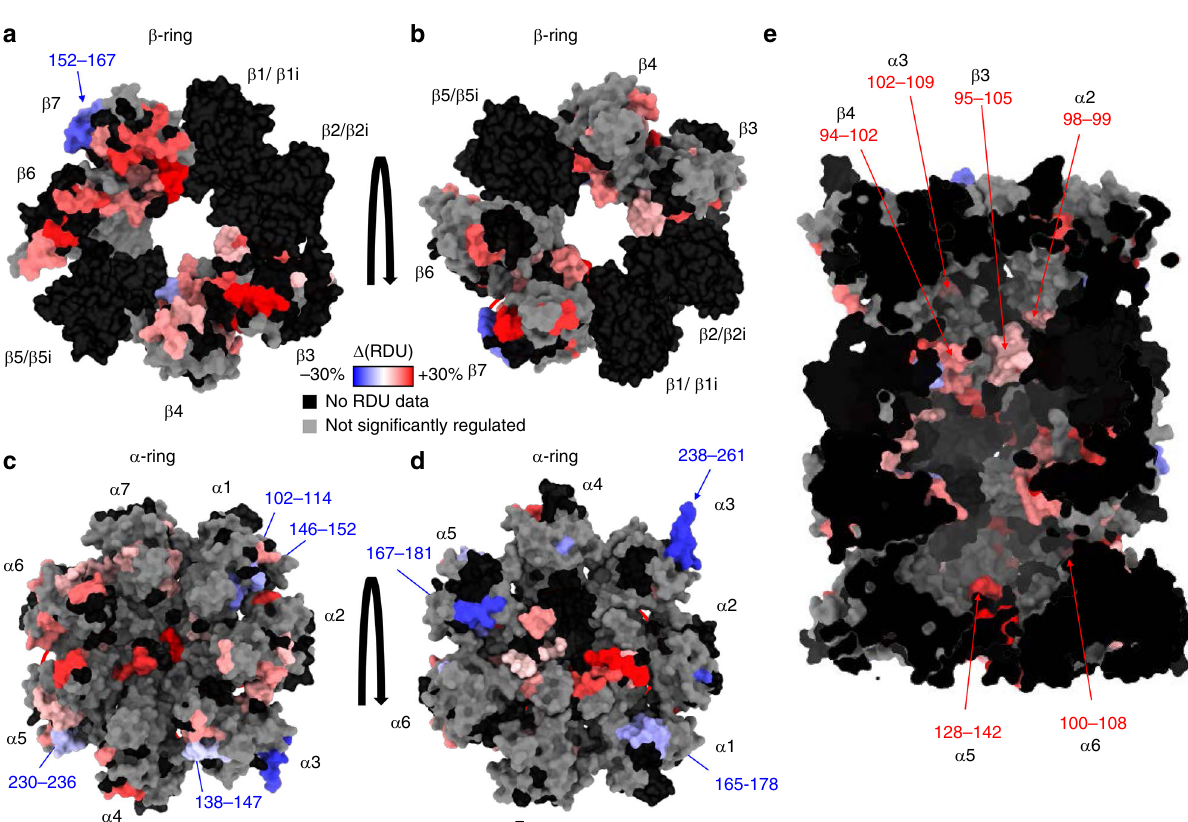
Fig. 4 Differential analysis of std20S and i20S. a – d Sum of differential relative uptakes between the i20S and the std20S ( Δ (RDU) = RDU i20S − RDU std20S ): β -ring/ β -ring interface ( a ); β -ring facing the α -ring ( b ); α -ring facing the β -ring ( c ); solvent-facing α -ring ( d ); inside view showing the antechambers and catalytic pockets ( e ). Color-coded regions were signi fi cantly more accessible/dynamic in the std20S (blue = − 30%) or i20S (red =+ 30%) and regions of interest are indicated with arrows. Regions that are not covered in one or both conditions, or do not pass the statistical threshold are represented in black and grey, respectively (see Fig. 1 for more details). RDU relative deuterium